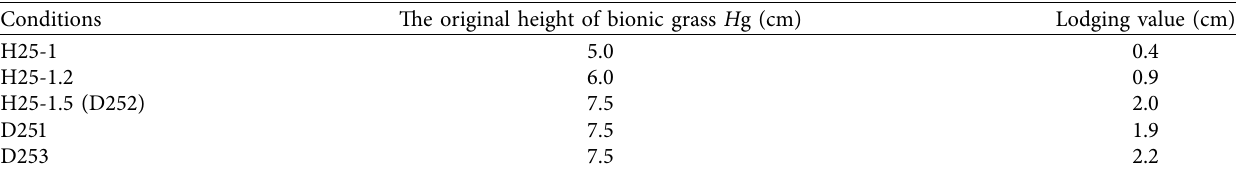
Table 2: Lodging value of bionic grass in conditions.